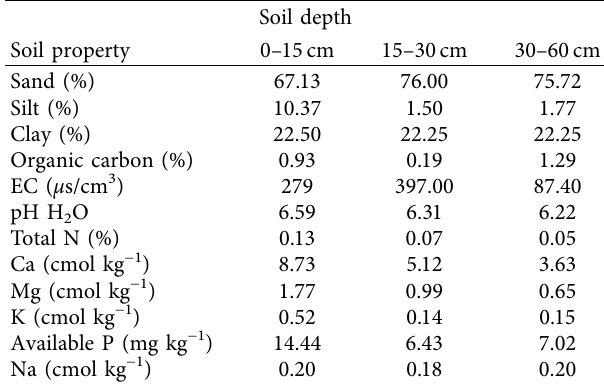
Table 1: Selected soil physico-chemical properties at the experi- mental